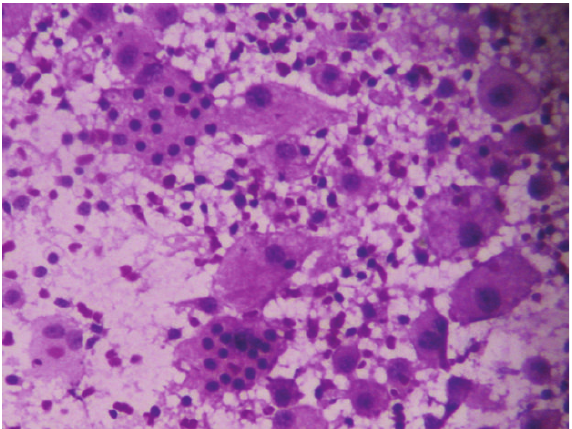
Figure 3: Many large histiocytes with binucleation and emperipole- sis, (FNAC, H&E ×